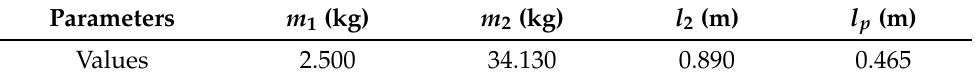
Table 1. Parameters of the crane system.